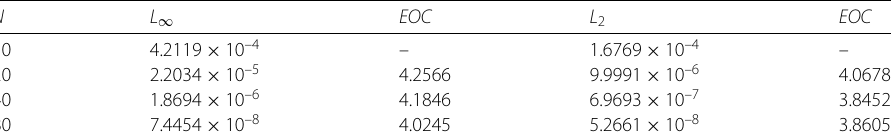
Table 6 Experimental order of convergence for Problem 2, when N = 80, α = 1.50, (cid:2) t = 0.001 N L